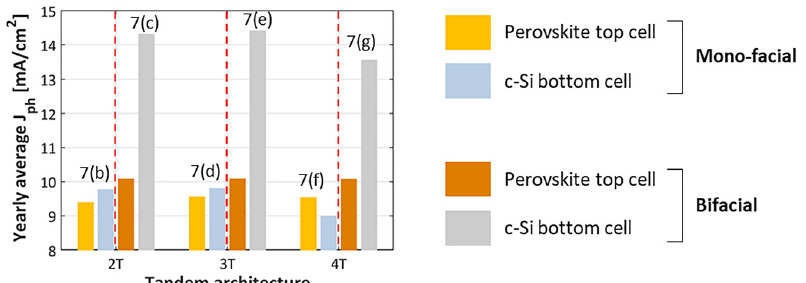
Figure 10: Comparison of yearly average photocurrent density of mono-facial and bi- facial 2T, 3T and 4T tandems with c-Si bot- tom cell passivated with poly-SiO x . Here bi- facial tandems are endowed with 700-nm thick perovskite absorber. Numbers and letters in the diagram refer to sub- fi gures in Figure